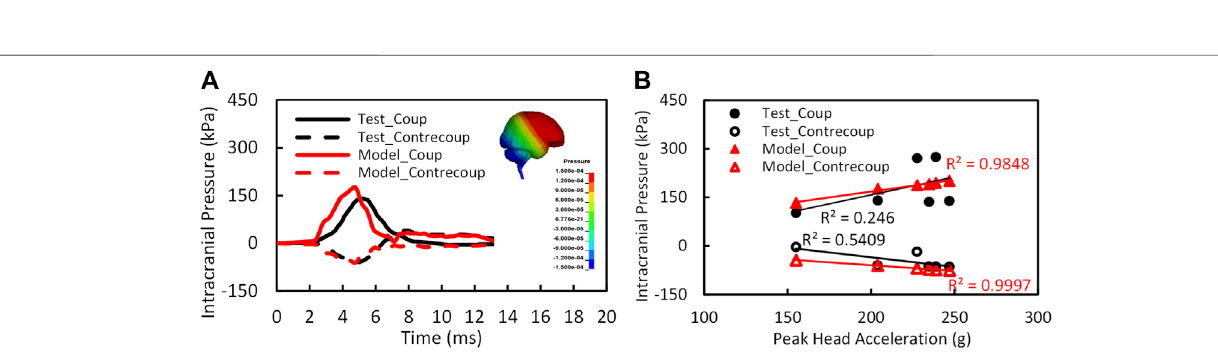
FIGURE3| Comparison ofGreenMPS – time historiesand peaks betweentheGHBMC modelsimulation and PMHStest (A) case C288-T3; (B) case C380T1; (C) case C380T2; (D) case C380T3; (E) case C380T4; (F) case C380T6; (G) case C393T3; (H) comparison of peak Green MPS.